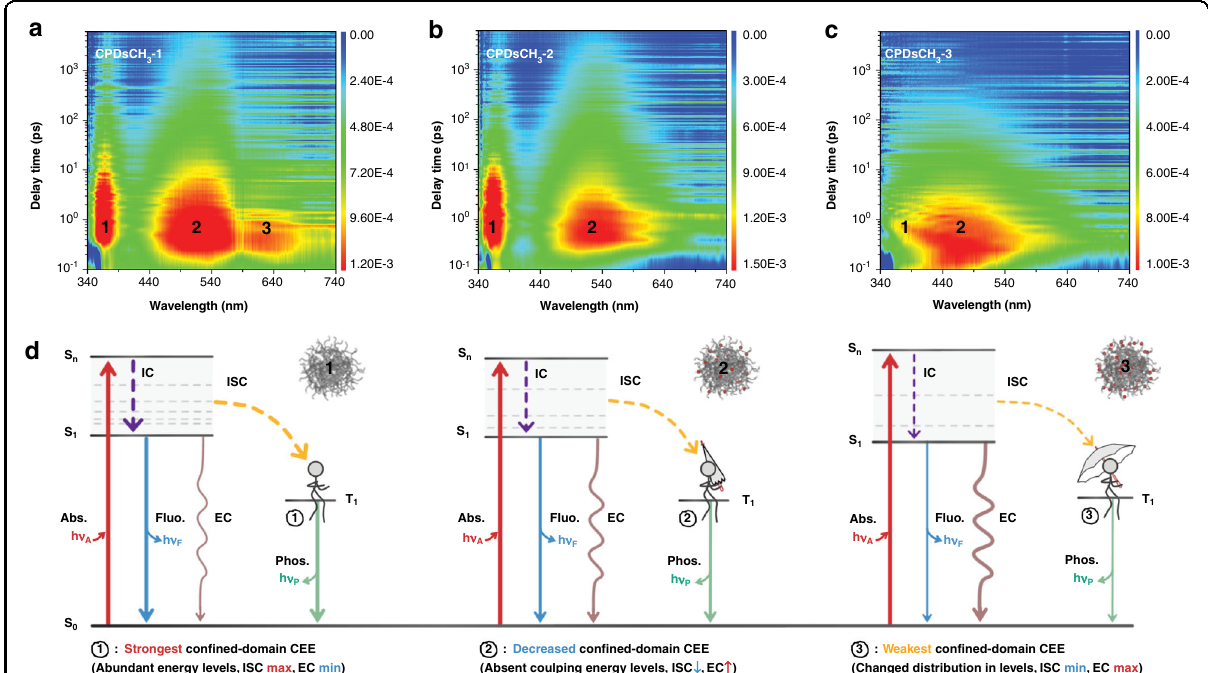
Fig. 4 Spatial interactions observed in the interior of CPDs (con fi ned-domain CEE). Two-dimensional pseudo-color TA maps of a CPDsCH 3 -1, b CPDsCH 3 -2, and c CPDsCH 3 -3 (excitation: 320 nm; probed in the range of 340~740 nm; scan delay times in the range of 0.1 ps~6 ns). d Schematic effect of con fi ned-domain CEE on the energy levels of CPDs (IC: internal conversion, Abs.: absorption, Fluo.: fl uorescence, Phos.: